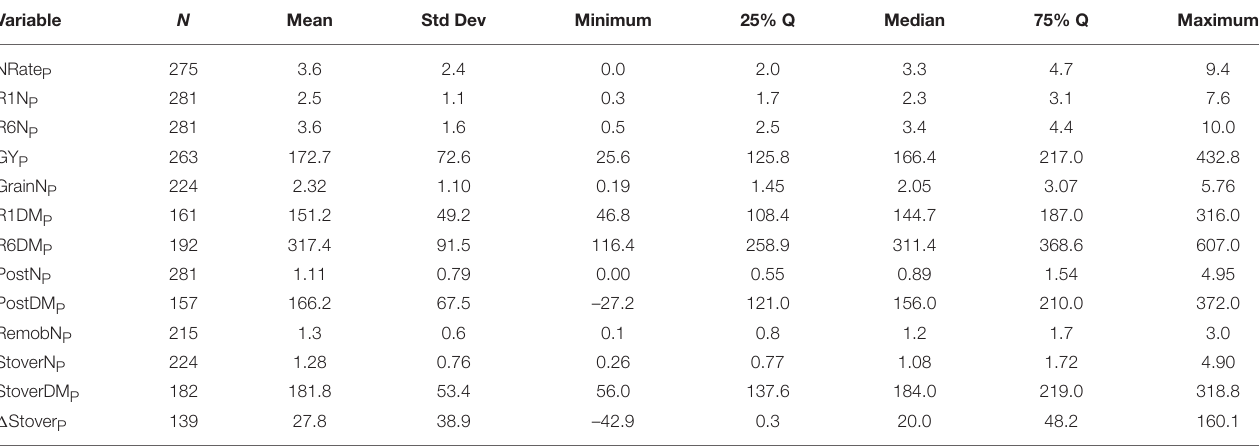
TABLE 4 | Summary statistics based on per plant determinations for the Old Era data set. Variable